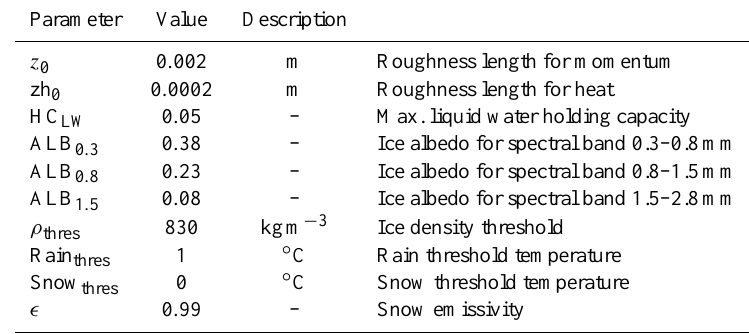
Table 1. Model parameters used for the reference run.